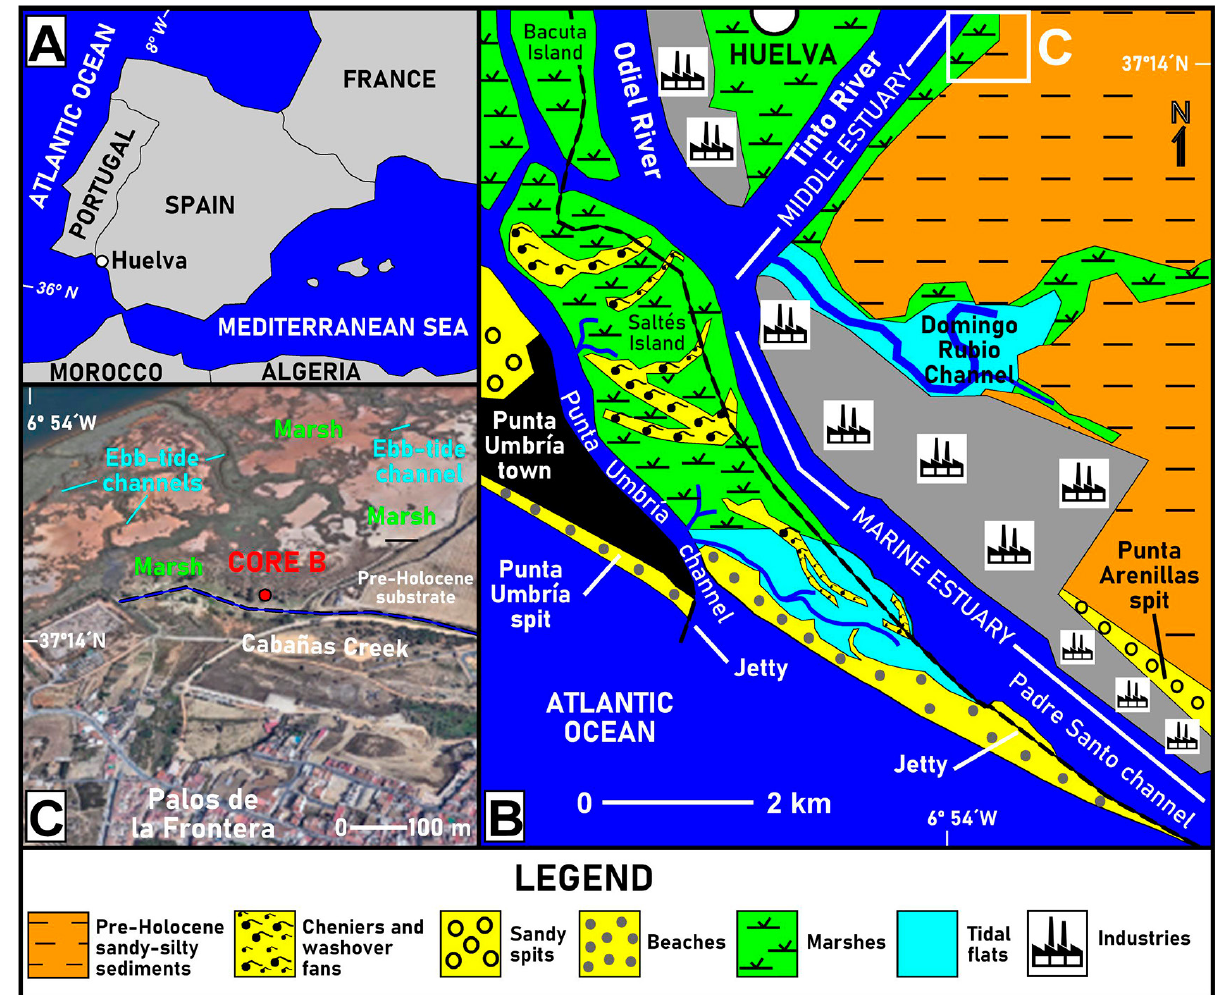
Fig. 1. – A-B, location and geomorphological map of the Tinto River estuary; C, location of core